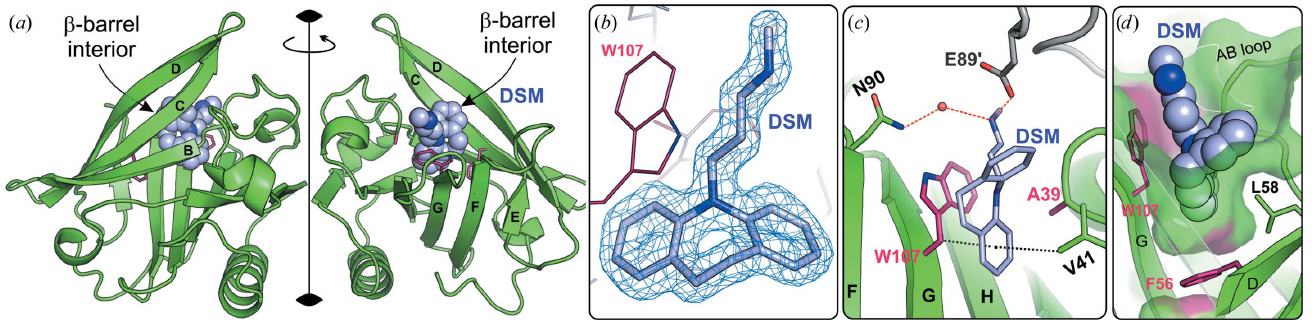
Figure 5 Structure of the FAF–DSM#3 complex. ( a ) The FAF dimer with crystallographically equivalent DSM binding sites inside the (cid:2) -barrel. The crystallographic dyad is represented by a vertical black line. ( b ) 2 F o (cid:3) F c electron-density map (1.5 (cid:6) ) around the DSM molecule in the FAF–DSM#3 complex (a difference omit map is presented in Supplementary Fig. S1). ( c ) Interactions stabilizing the DSM molecule inside the (cid:2) -barrel: hydrogen bonds (red dashed lines) and C—H (cid:7)(cid:7)(cid:7) (cid:3) interactions (black dashed lines). ( d ) The shape of the binding pocket and the pose of the DSM ligand in the (cid:2)